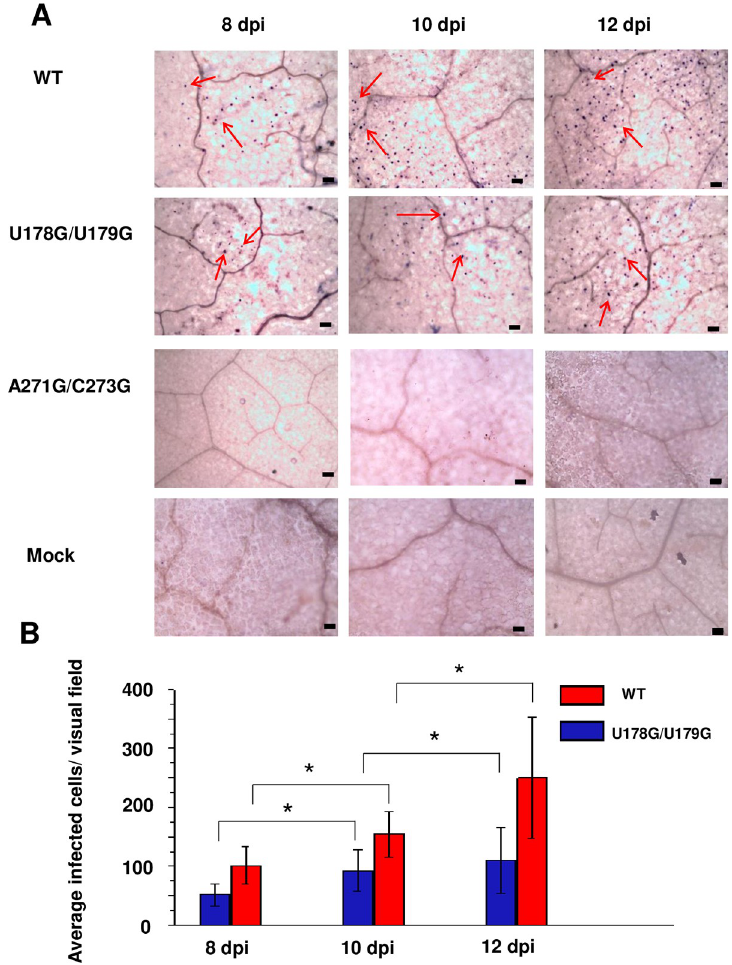
Fig 6. U178G/U179G replicates and spreads in rub-inoculated leaves. (A) Whole-mount in situ hybridization was used to monitor infection in leaves rub-inoculated with wild type PSTVd (WT), U178G/U179G, and replication defective A271G/C273G (negative control) at 8, 10, and 12 days post-inoculation (dpi). Mock inoculation was another negative control. Purple dots (red arrows) are viroid hybridization signals in nuclei. Bars = 100 μ m. Images for PSTVd WT and U178G/U179G are representative of more than 200 visual fields. (B) Mean numbers of infected cells per visual field after U178G/U179G (blue) and WT (red) inoculation. Asterisks indicate significant differences (p < 0.05) as determined by Student’s t test. Bars indicate standard error of the